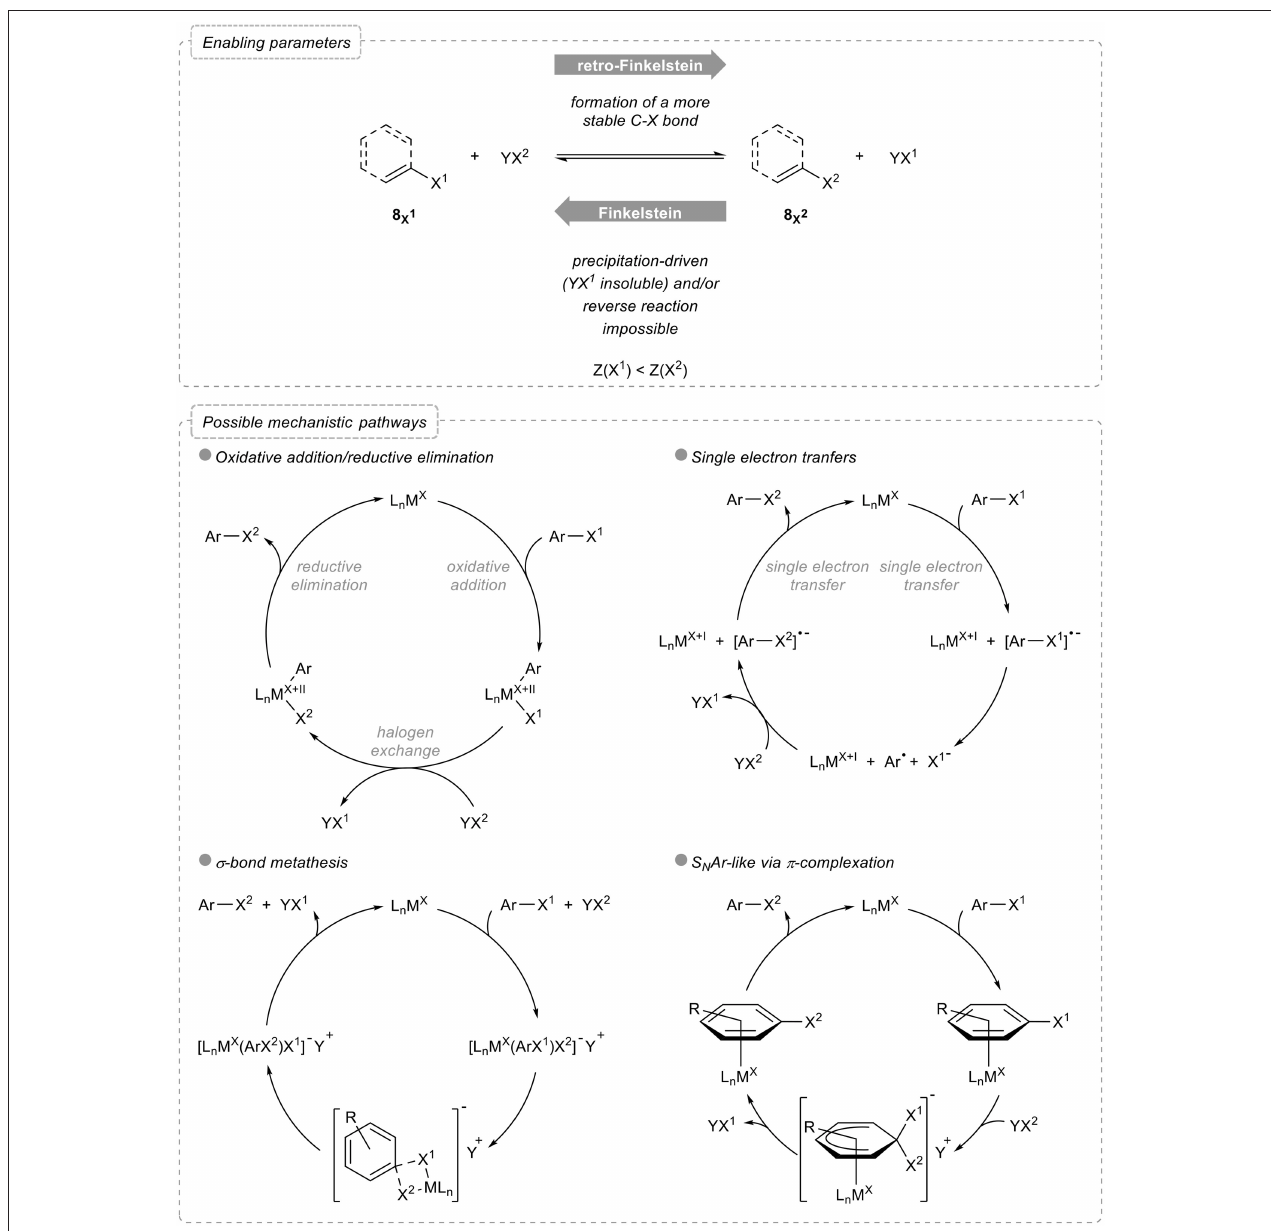
FIGURE 2 | Halogen exchange in aryl and vinyl halides: enabling parameters and possible mechanistic pathways.